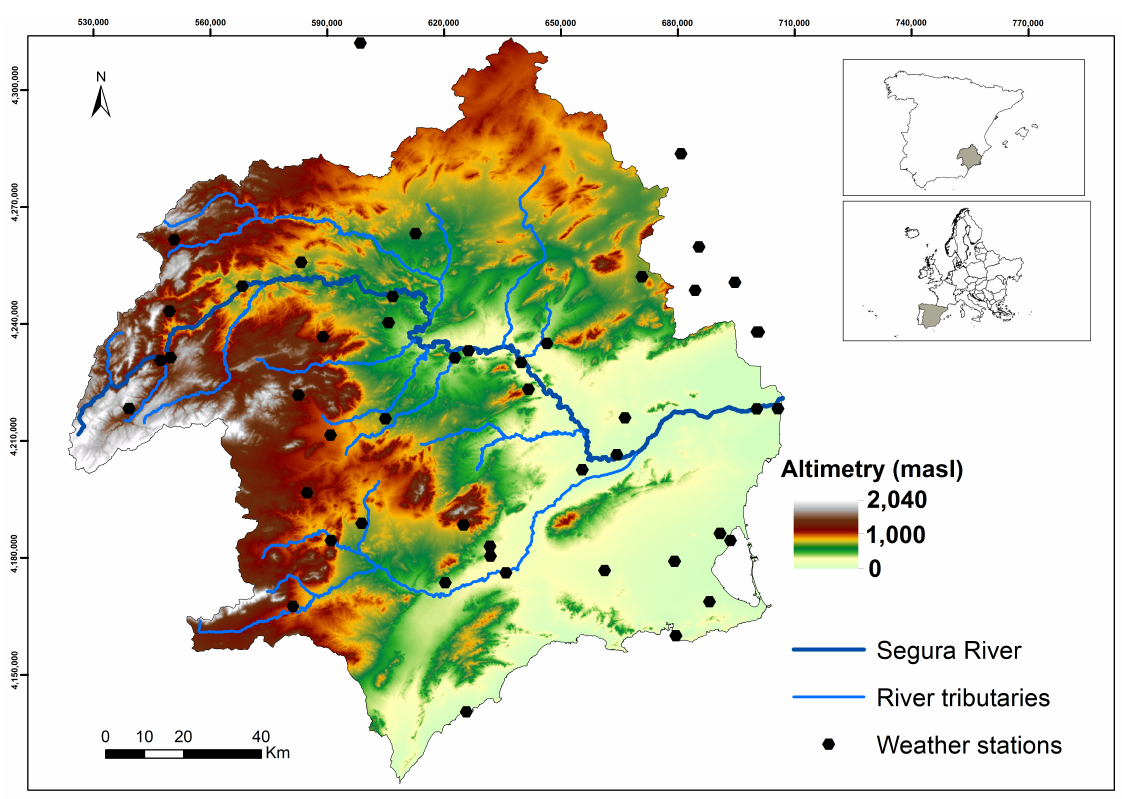
Figure 1. Study area including the 48 weather stations of the AEMET network used in this